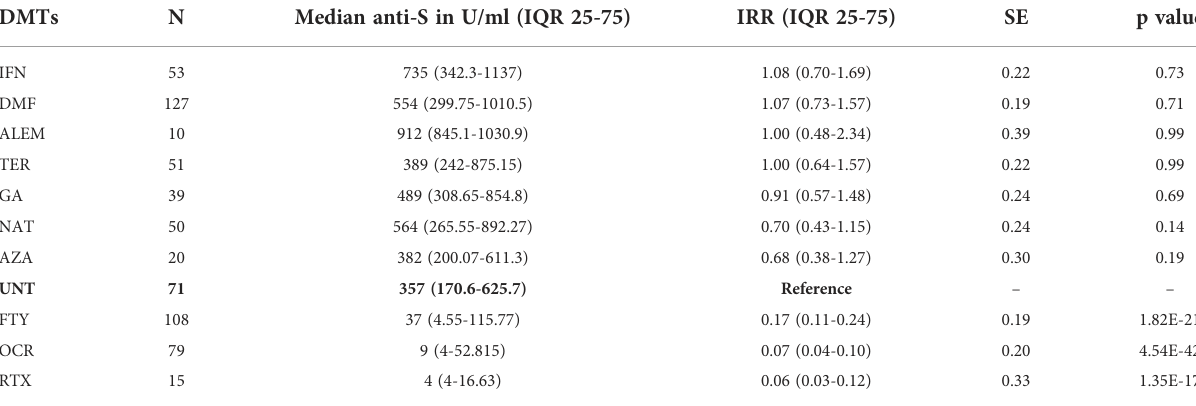
TABLE 2 Negative binomial generalized linear mixed-effects model of anti-S-Ab levels in untreated and treated MS patients (anti-N negative) 6 months after the second dose (T2) of BNT162b2 vaccine. DMTs